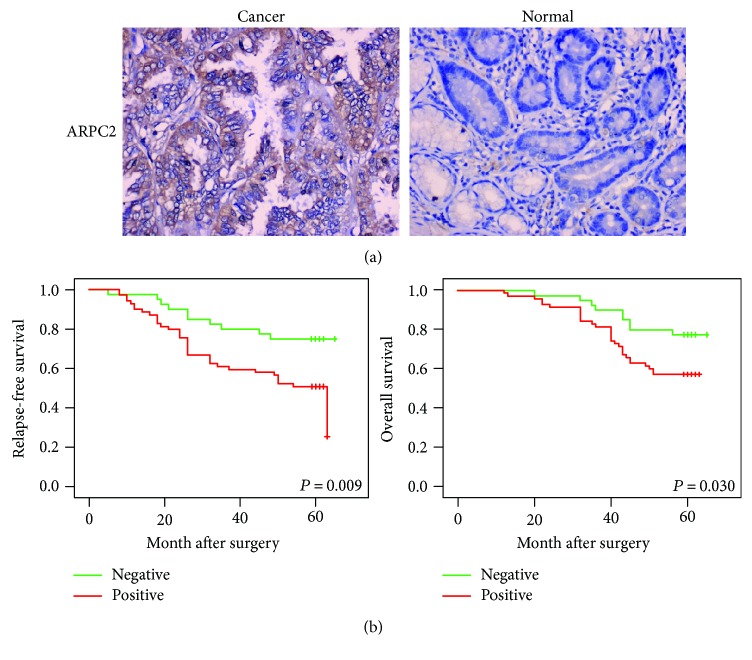
Relapse-free and overall survival curves stratified by ARPC2 expression. (a) Expression of ARPC2 protein in normal gastric tissues and gastric cancer tissues was detected using immunohistochemistry method, and representative pictures are shown. Magnification: 200. (b) Gastric cancer patients with positive expression of ARPC2 were associated with worse relapse-free survival and overall survival.